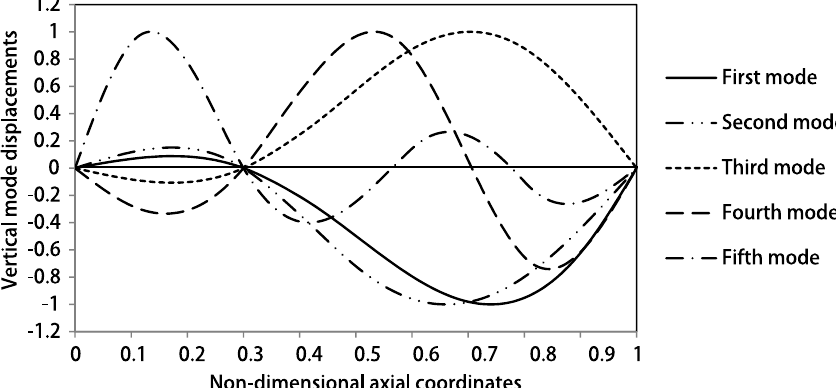
Fig. 7. The lowest five mode shapes of a single-span uniform beam carrying three point masses, two rotary inertias, two linear springs, two rotational springs and two spring-mass systems and subjected to axial load.